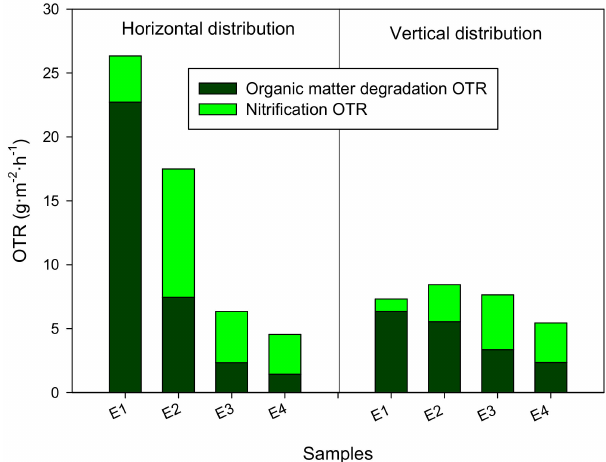
Figure 8. Oxygen transfer rate along the treatment in both pilot